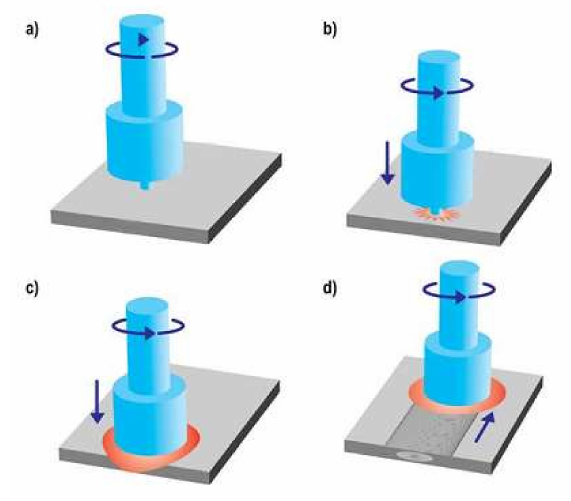
Figure 5. Schematic showing different steps in friction stir processing [27]. (Open